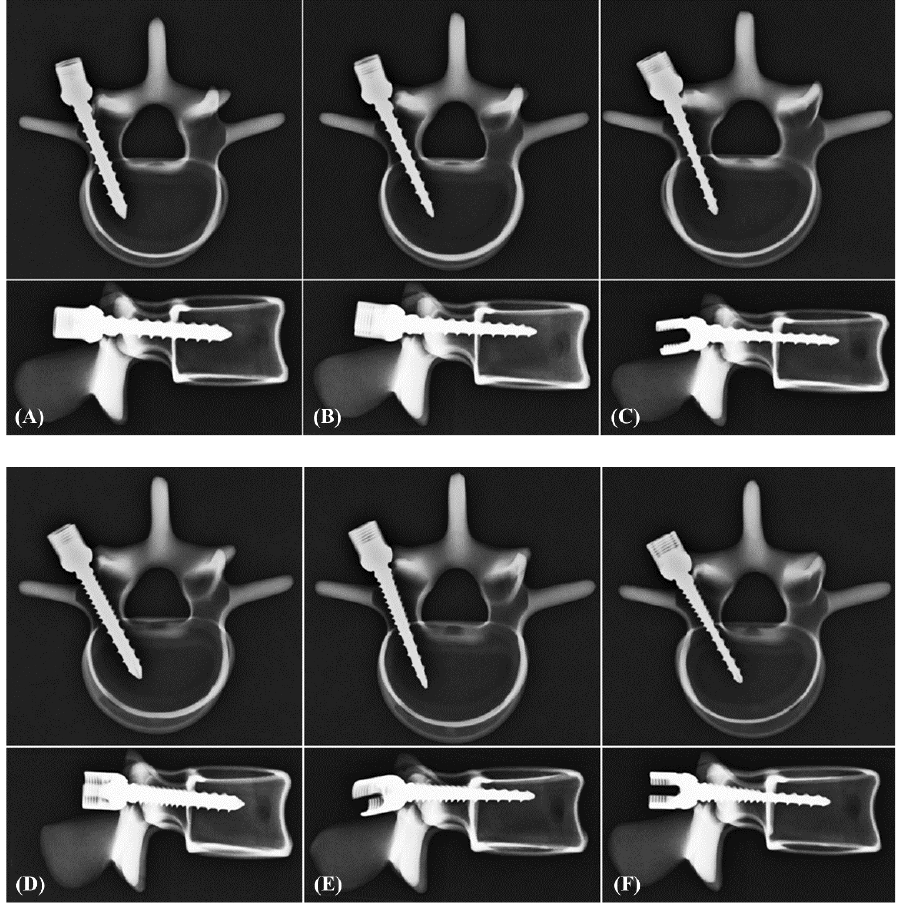
Figure 2. Axial ( upper ) and sagittal ( lower ) X ‐ ray images of the vertebrae after the insertion of screws with various geometries. ( A ) S ‐ Cy, ( B ) S ‐ Co, ( C ) S ‐ PCo, ( D ) D ‐ Cy, ( E ) D ‐ Co, and ( F ) D ‐ PCo.